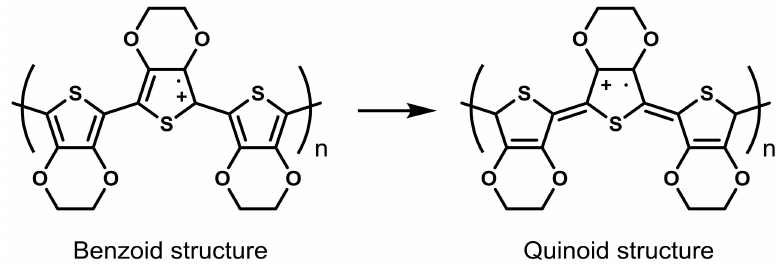
Figure 5. Difference between benzoid and quinoid forms (extended-coil structure) of